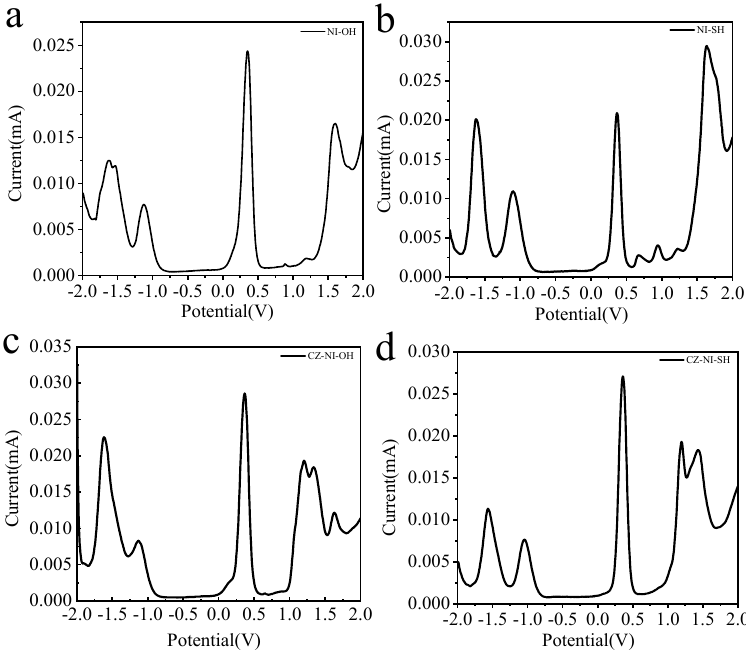
Figure 1. DPV curves of small molecules NI-OH ( a ), NI-SH ( b ), CZ-NI-OH ( c ) and CZ-NI-SH ( d ).